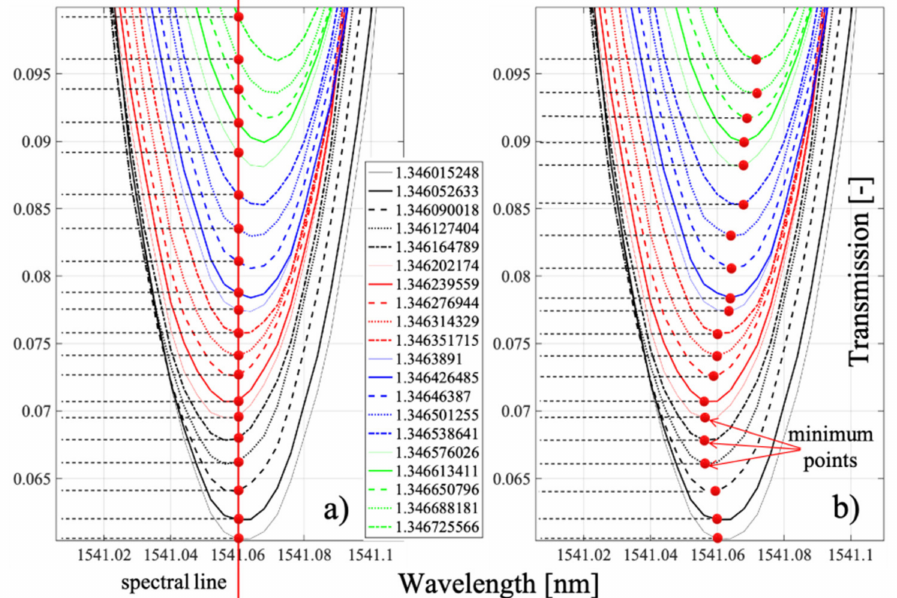
Figure 26. Graphical representation of how to determine refractive index changes using the P-TFBG structure: ( a ) spectral line method, ( b ) minimum tracking